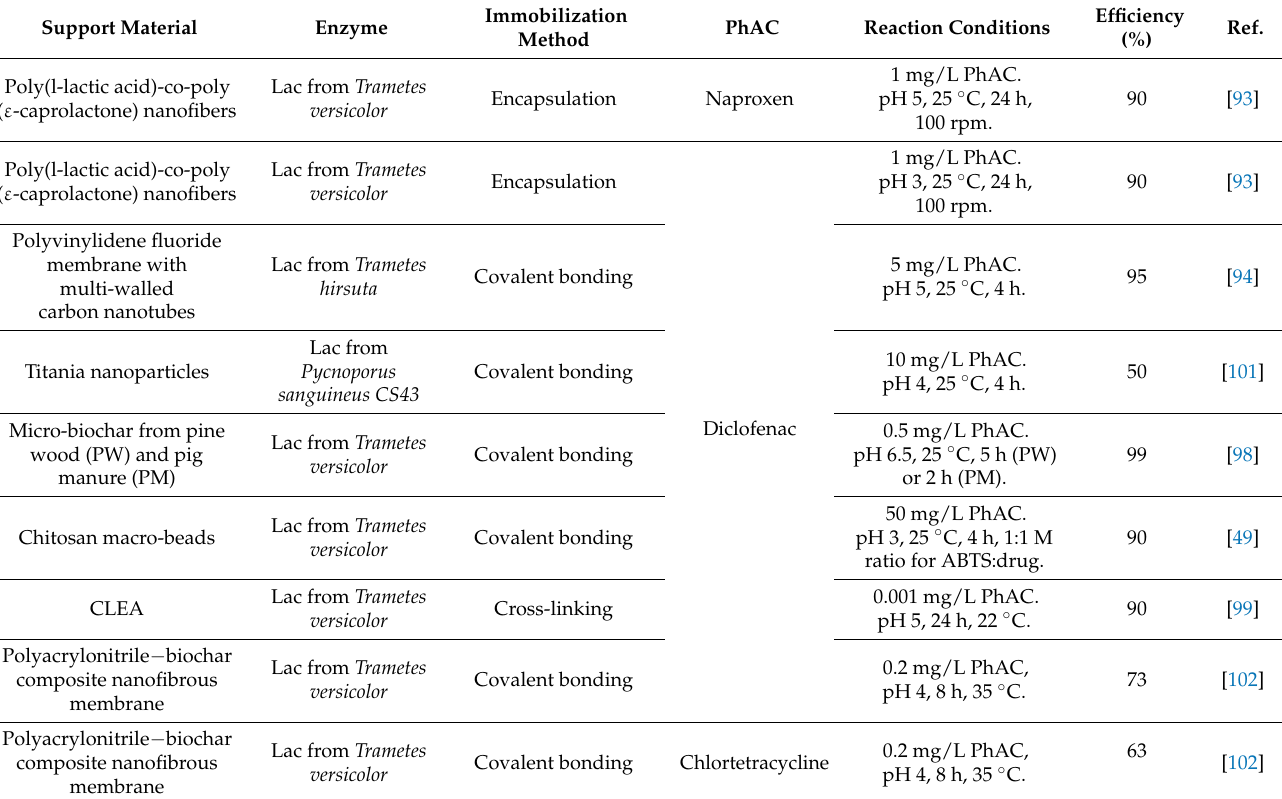
Table 4. Examples of the removal of pharmaceutical compounds by immobilized